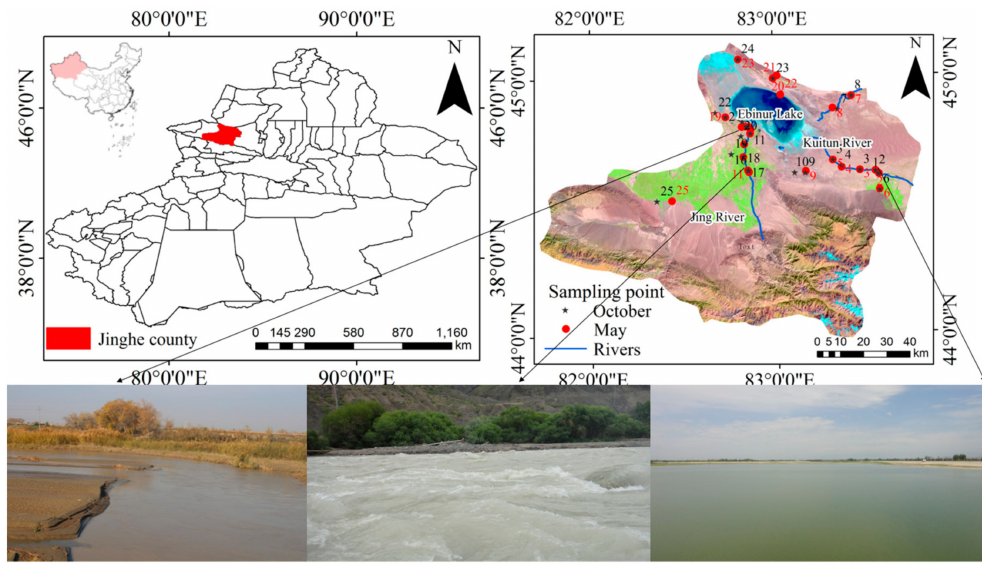
Figure 1. Location and sampling points of the study